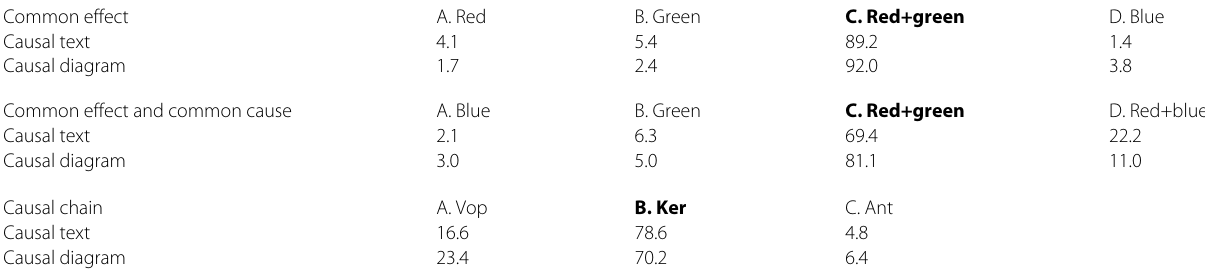
Table 4 Percentage of subjects selecting each answer for the control questions in Experiment 4 Common